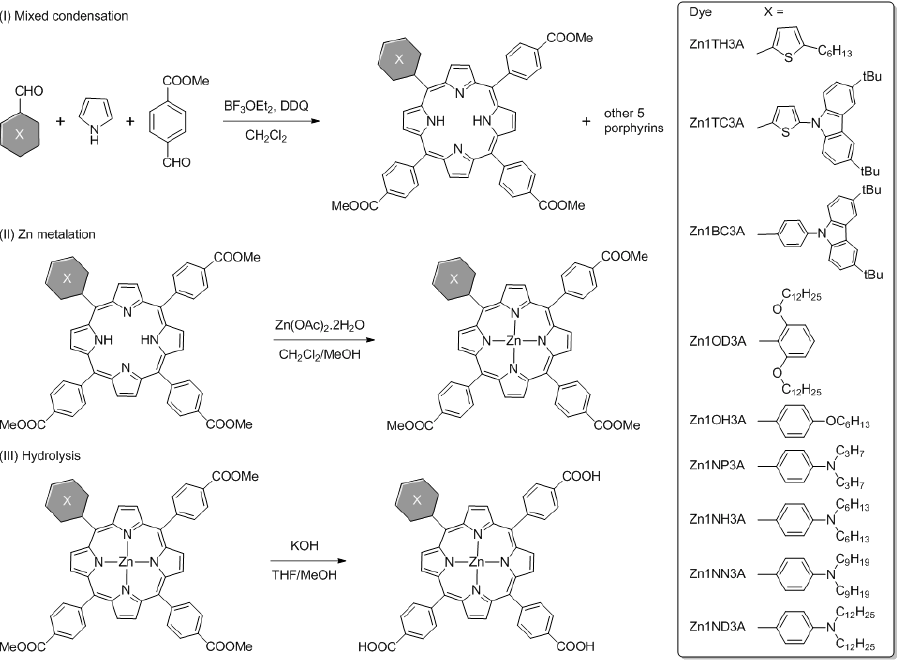
Figure 1. Ultraviolet visible (UV/Vis) spectra of the 1D ‐π‐ 3A porphyrin sensitizers in tetrahydrofuran.